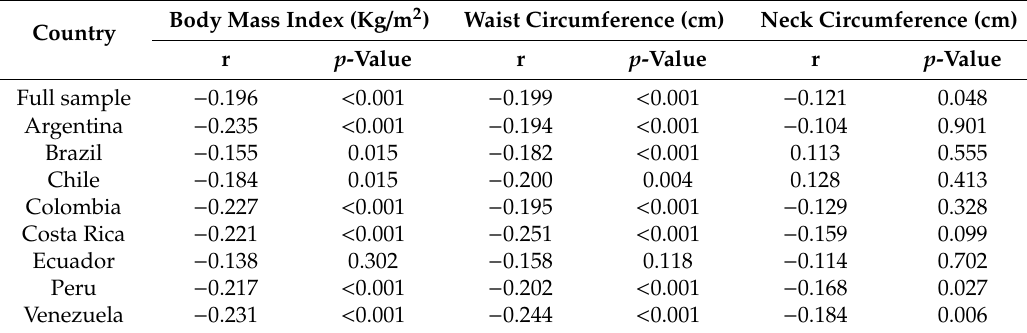
Table 2. Correlation between active transportation and obesity indicators per